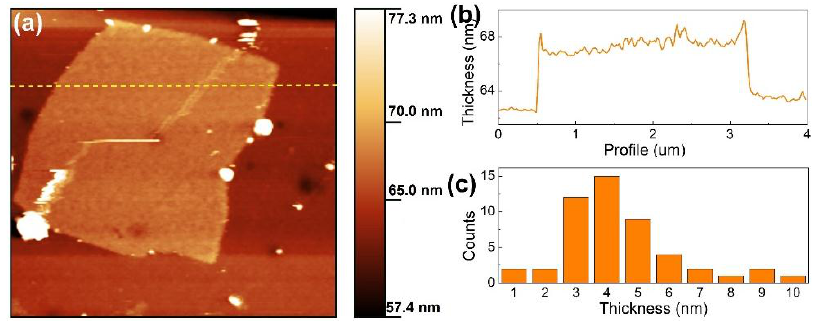
Figure 4. ( a ) Typical atomic force microscopy (AFM) image; ( b ) corresponding thickness profile along the yellow dashed line in ( a ), and ( c ) thickness distribution of the exfoliated g-C 3 N 4 with 1 h acid treatment.